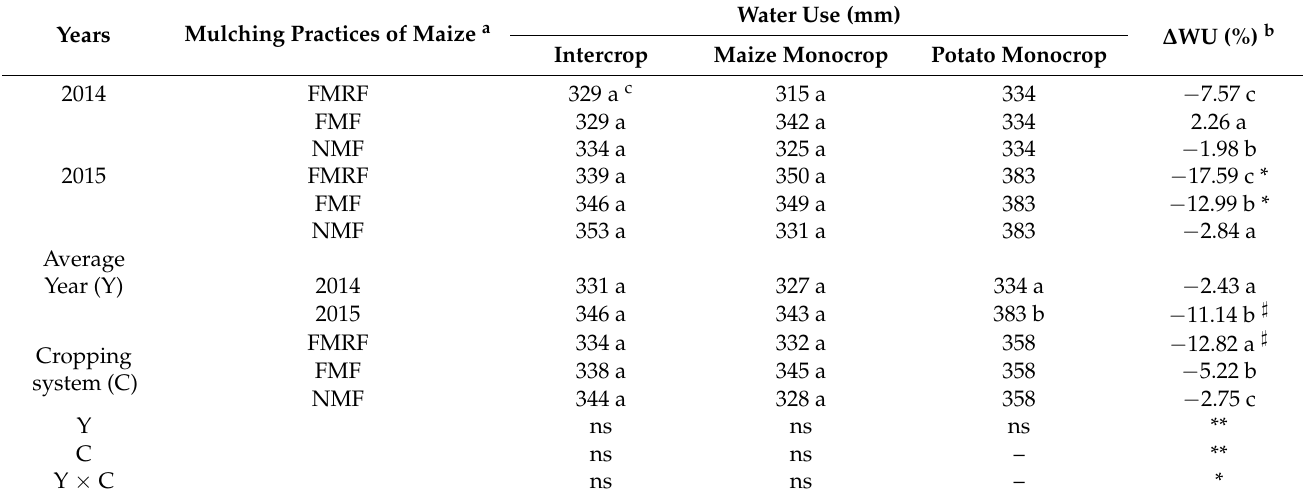
Table 6. Water use (WU) of the intercropping system compared with monocrop in